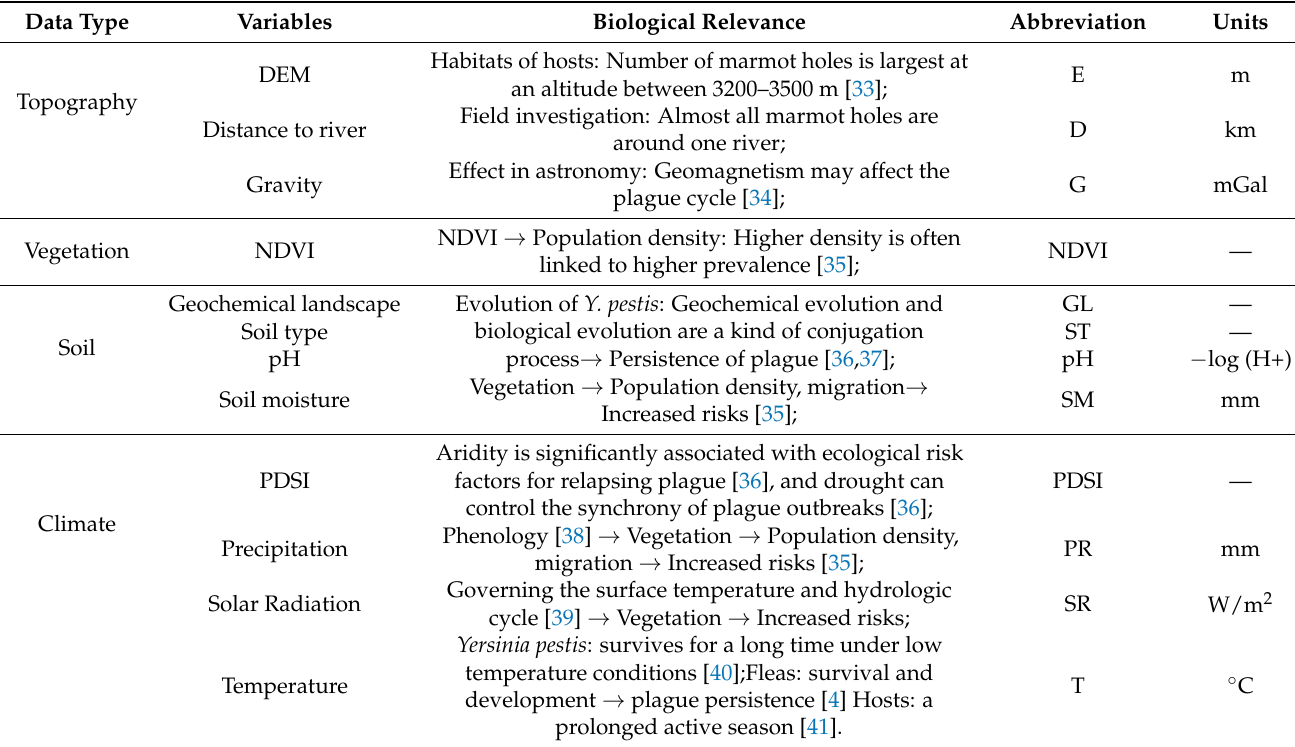
Table 1. Environmental variables used in Maxent models for Himalaya plague in the